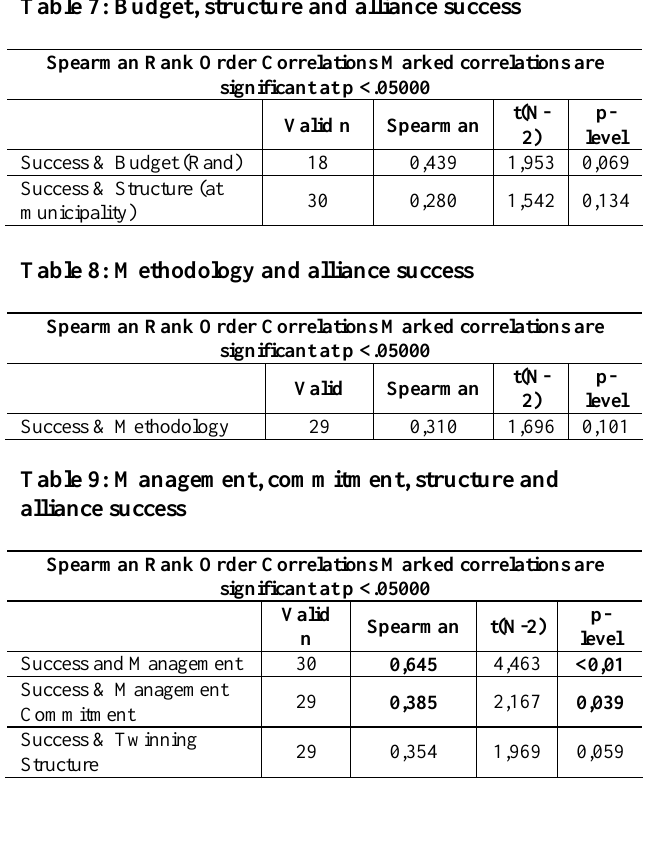
Table 7: Budget, structure and alliance success